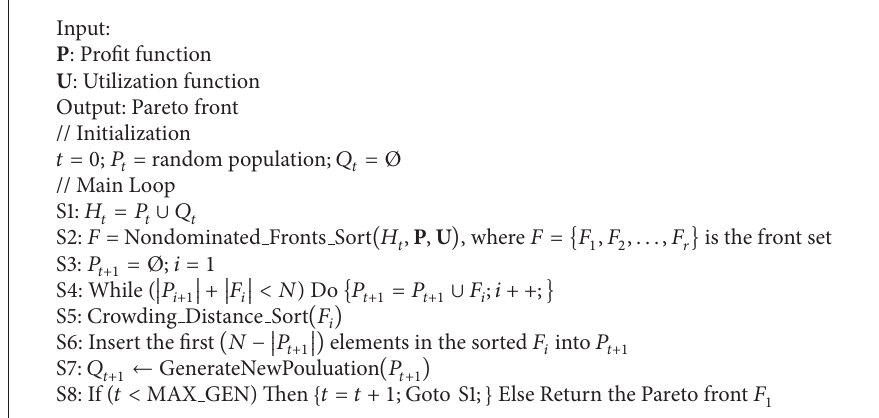
Algorithm 1: Pricing resources with profit and satisfaction optimization (PRPSO) algorithm.